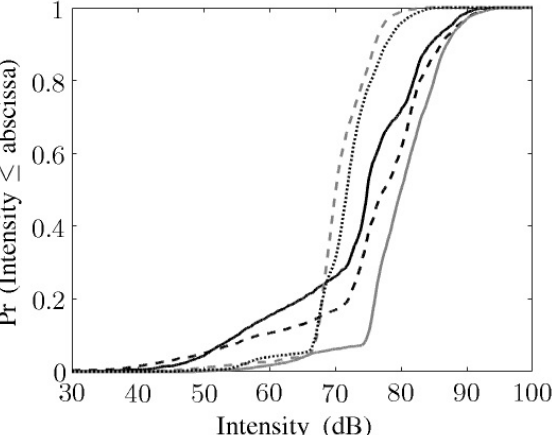
Figure 19. Cumulative distribution function of pixel intensity on SAR image. ——— : Arleigh Burke-class destroyer, − − − : Ticonderoga-class cruiser, ——— : Slava-class cruiser, − − − : Type 055 destroyer, · · · : Type 45 destroyer.